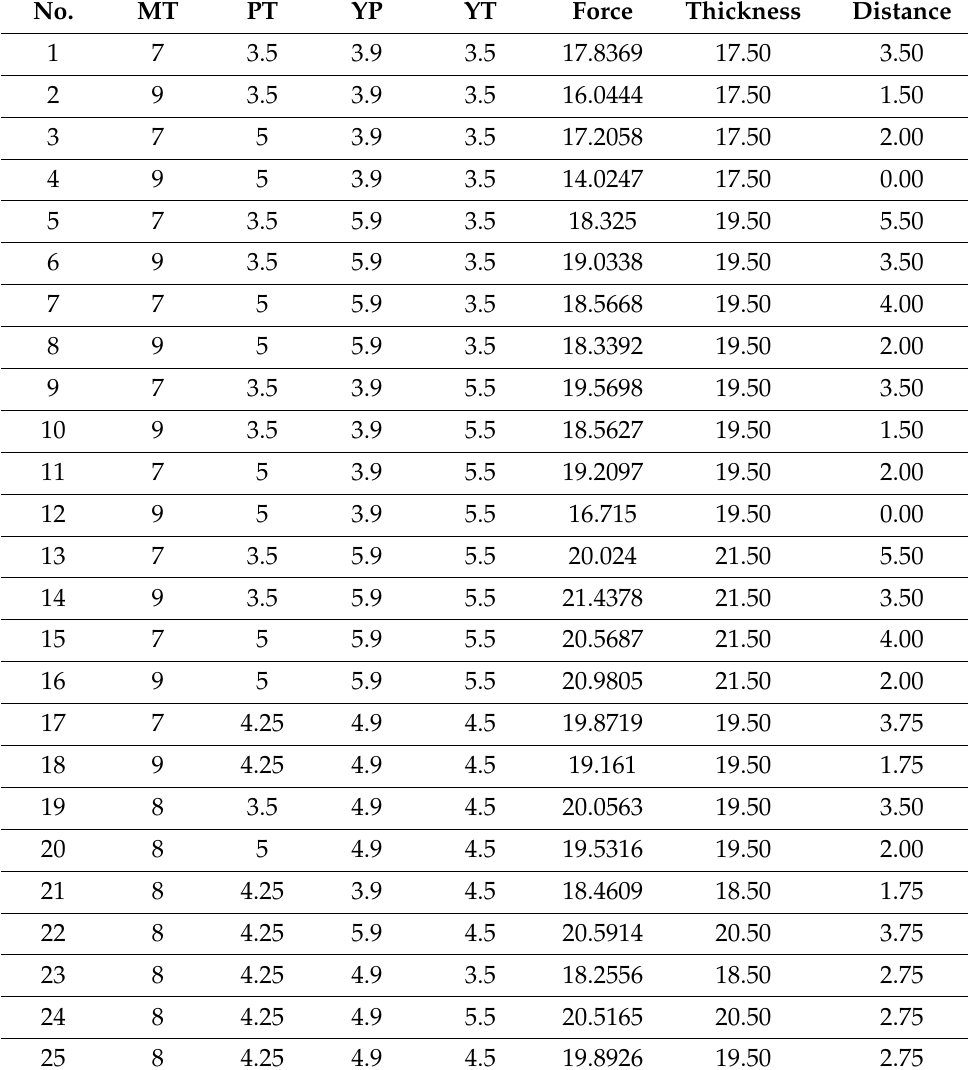
Table 5. Response surface design matrix and results of vertical magnetization